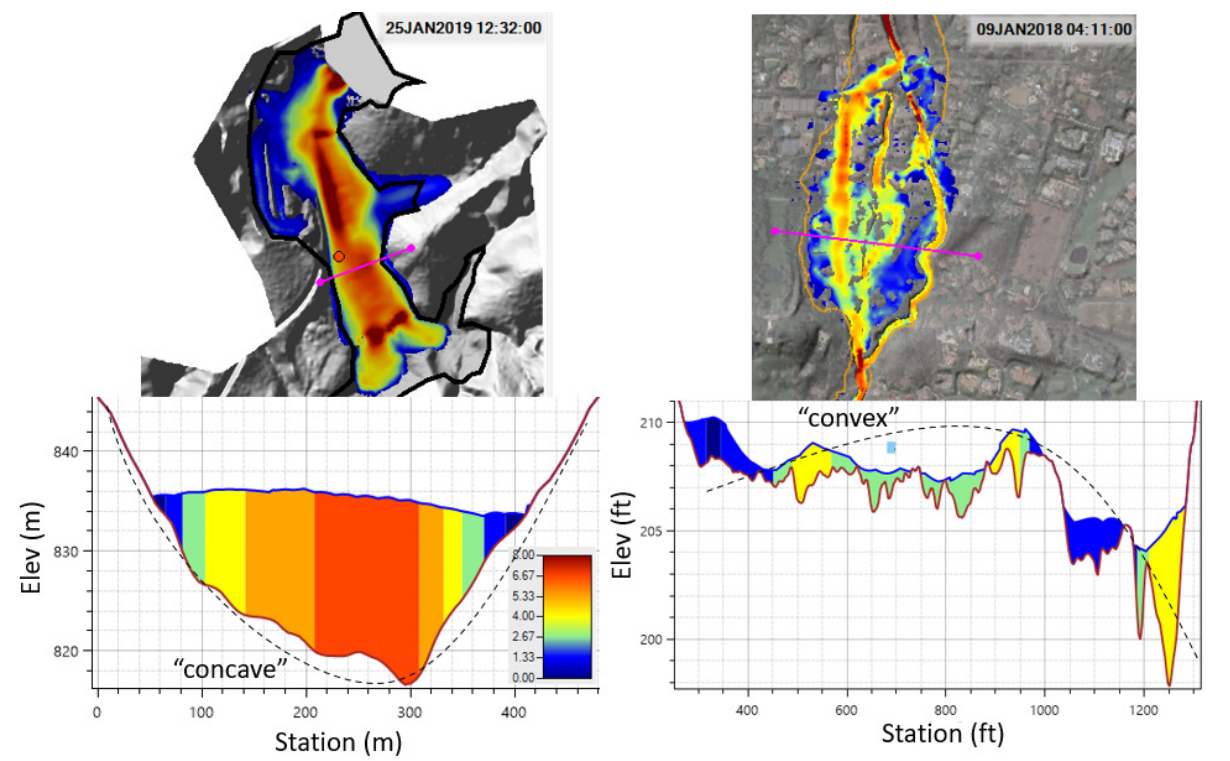
Figure 7. “Concave,” river ‐ valley, bathymetry ( left ) of the Brumadinho dam breach made this event more predictable than the “convex,” alluvial fan bathymetry (and history) of Santa Barbara ( right ).